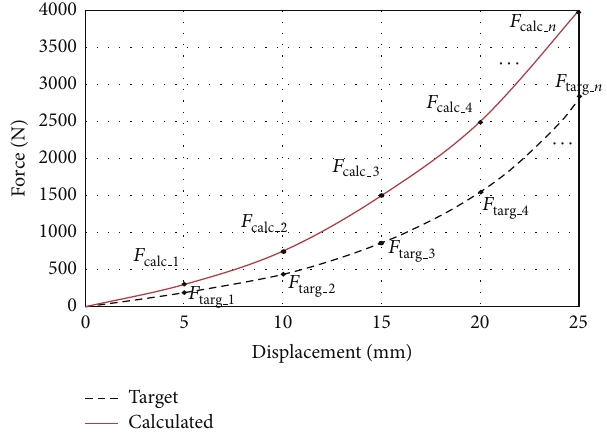
Figure 8: Chi-square calculation points.